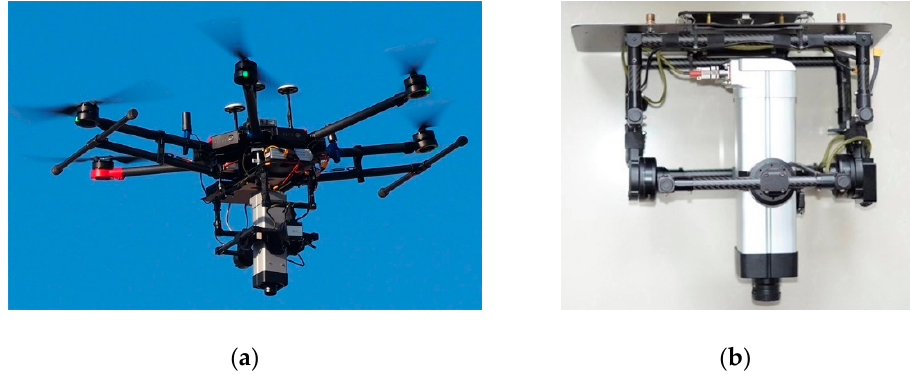
Figure 1. UAV hyperspectral system used in the study: ( a ) M600 Pro UAV platform with the hyperspectral imaging system onboard; ( b ) The ZK-VNIR-FPG480 hyperspectral imaging spectrometry system. Table 1. Technical indicators of ZK-VNIR-FPG480 hyperspectral